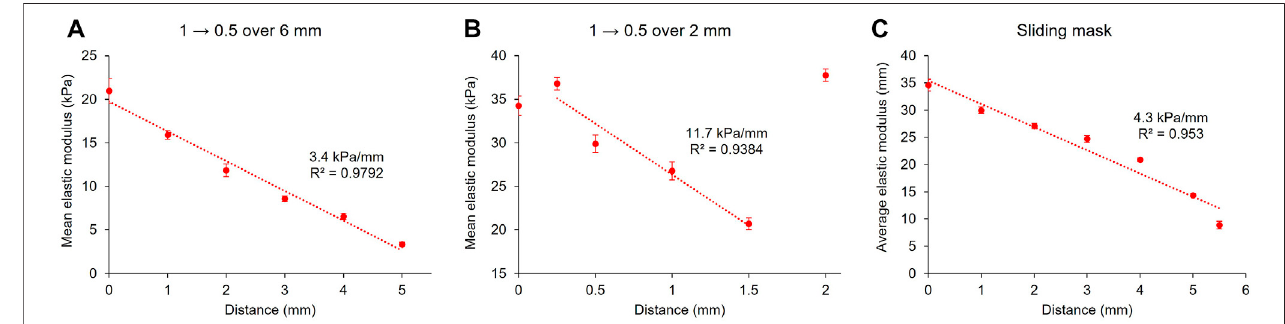
FIGURE7| Stiffnessgradientswiththeprojectorset-up.10 wt%GelMAhydrogelswerecrosslinkedfor4 minwithagradientrangingfromgreyscalevaluesof1to 0.5 over a distance of approximately 6 mm (A) or 2 mm (B) . Another method to produce a stiffness gradient with a sliding mask was also used (C) . Error bars: standard deviation of the elastic modulus over the force maps.